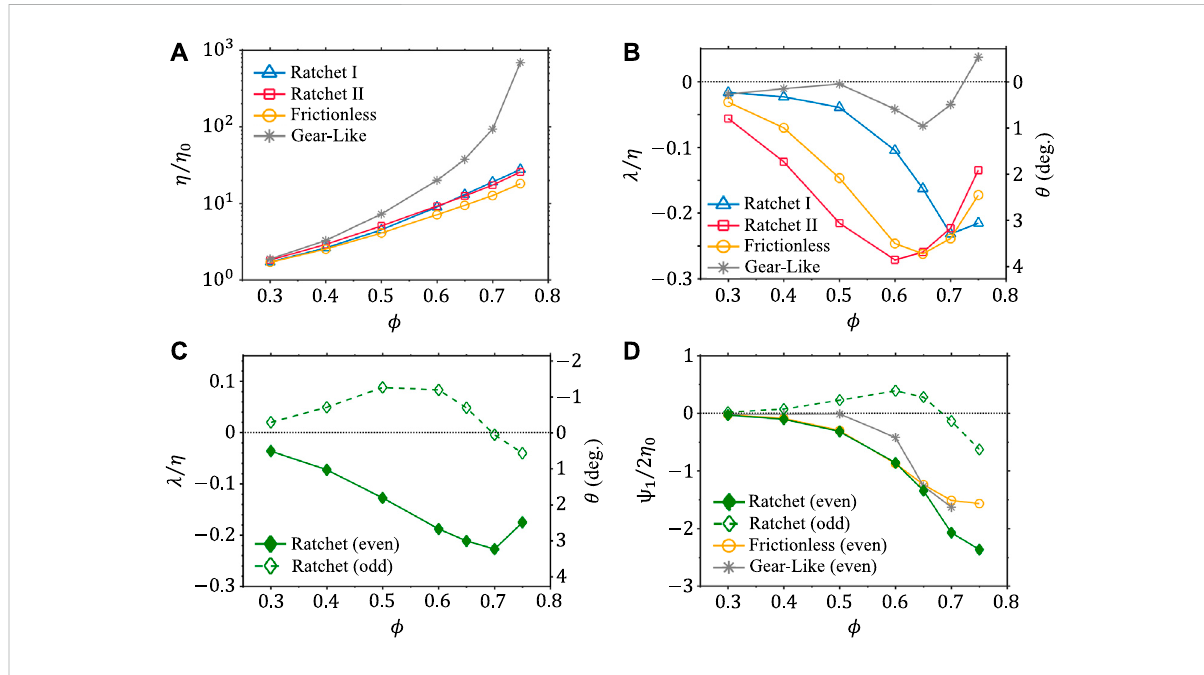
FIGURE 3 (A) Relativeshearviscosity η / η 0 and (B) ratioofnon-dissipationresponsefunctiontoshearviscosity λ / η andcorrespondingreorientation angle θ as a function of particle areal fraction ϕ for various particle models. (C) Even and odd components of the ratio λ / η as a function of ϕ for ratchet particles. (D) Scaled fi rst normal stress coef fi cient as a function of ϕ for various particle models. In the fi gures, error bars are not shown because they are smaller than the